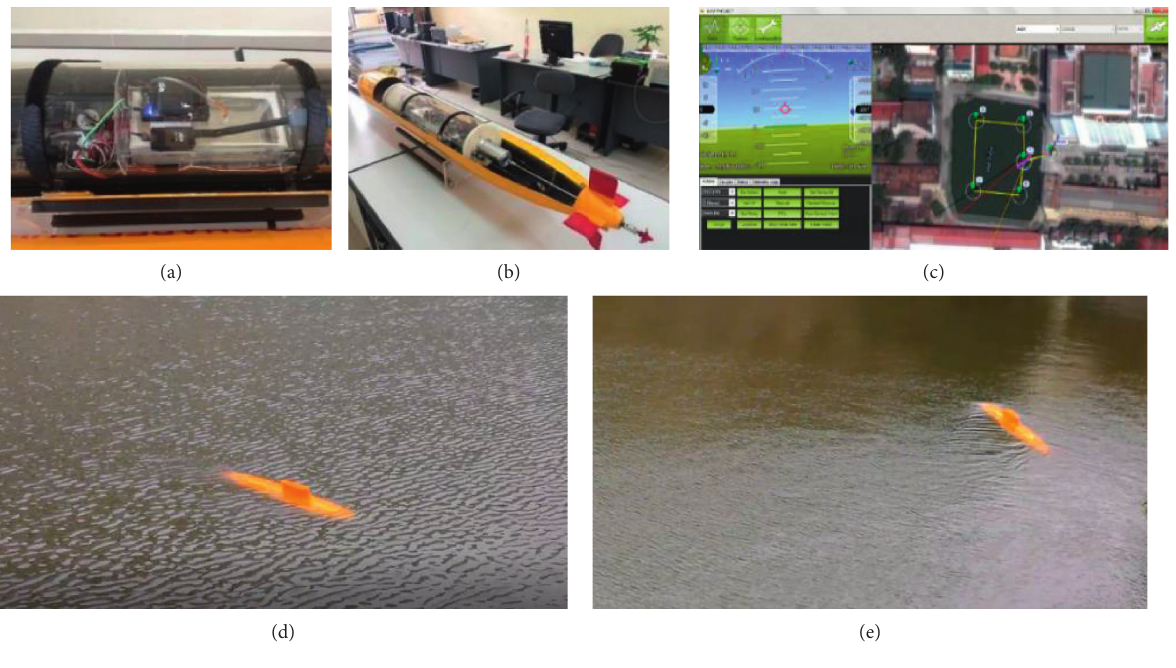
Figure 8: Installation and trial trips for the M-AUV controller. Table 3: Main operational parameters of the